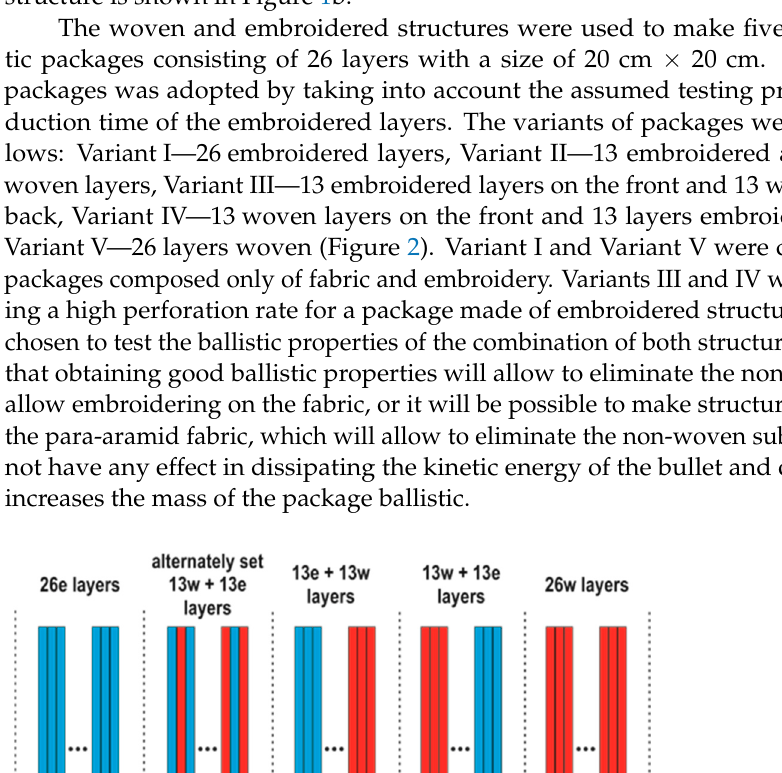
thread zigzagged, 5—thread bottom, 6—swivel hook, and 7—embroidered structure), ( b ) view of the embroidered structure produced.